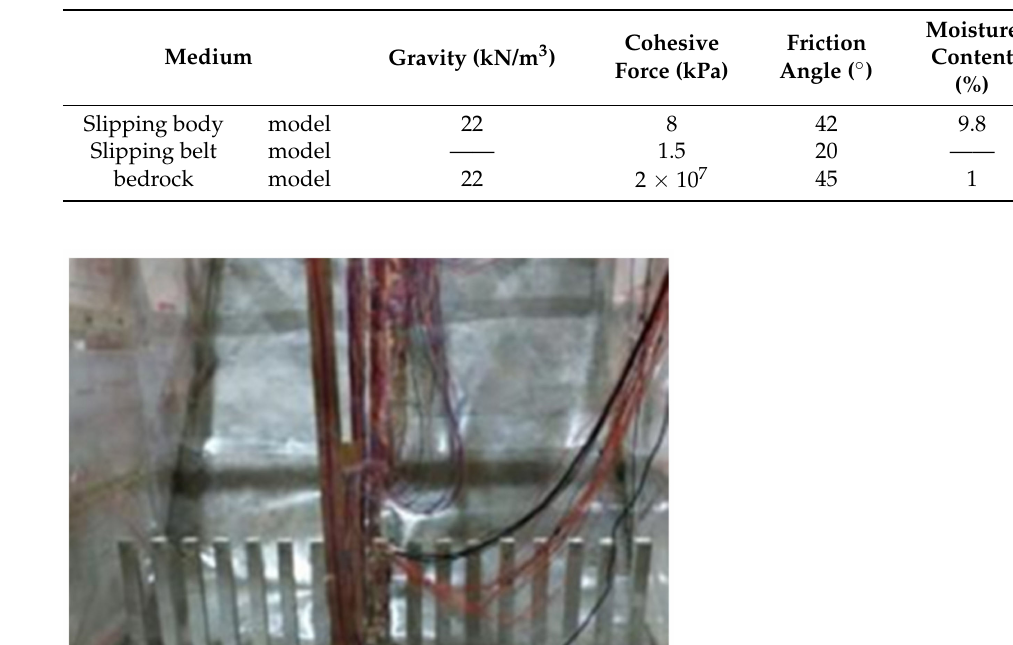
Table 4. Physico-mechanical indexes of model materials.